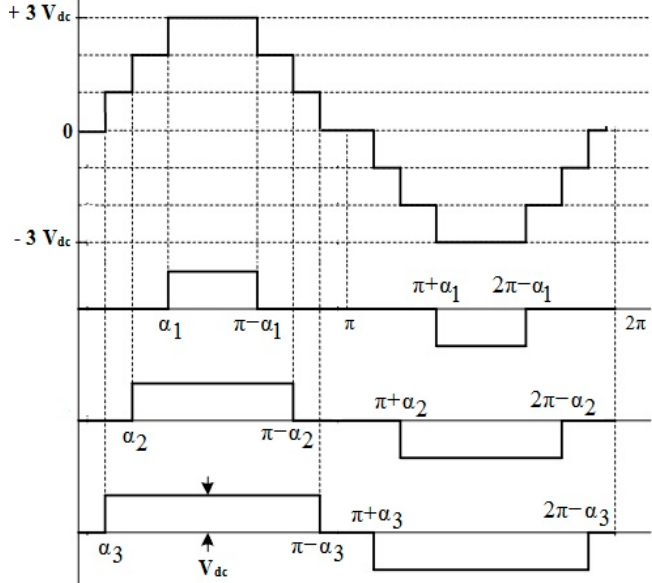
Figure 8. Generation of the seven-level stepped voltage waveform for DCLCHB inverter using CAD techniques.